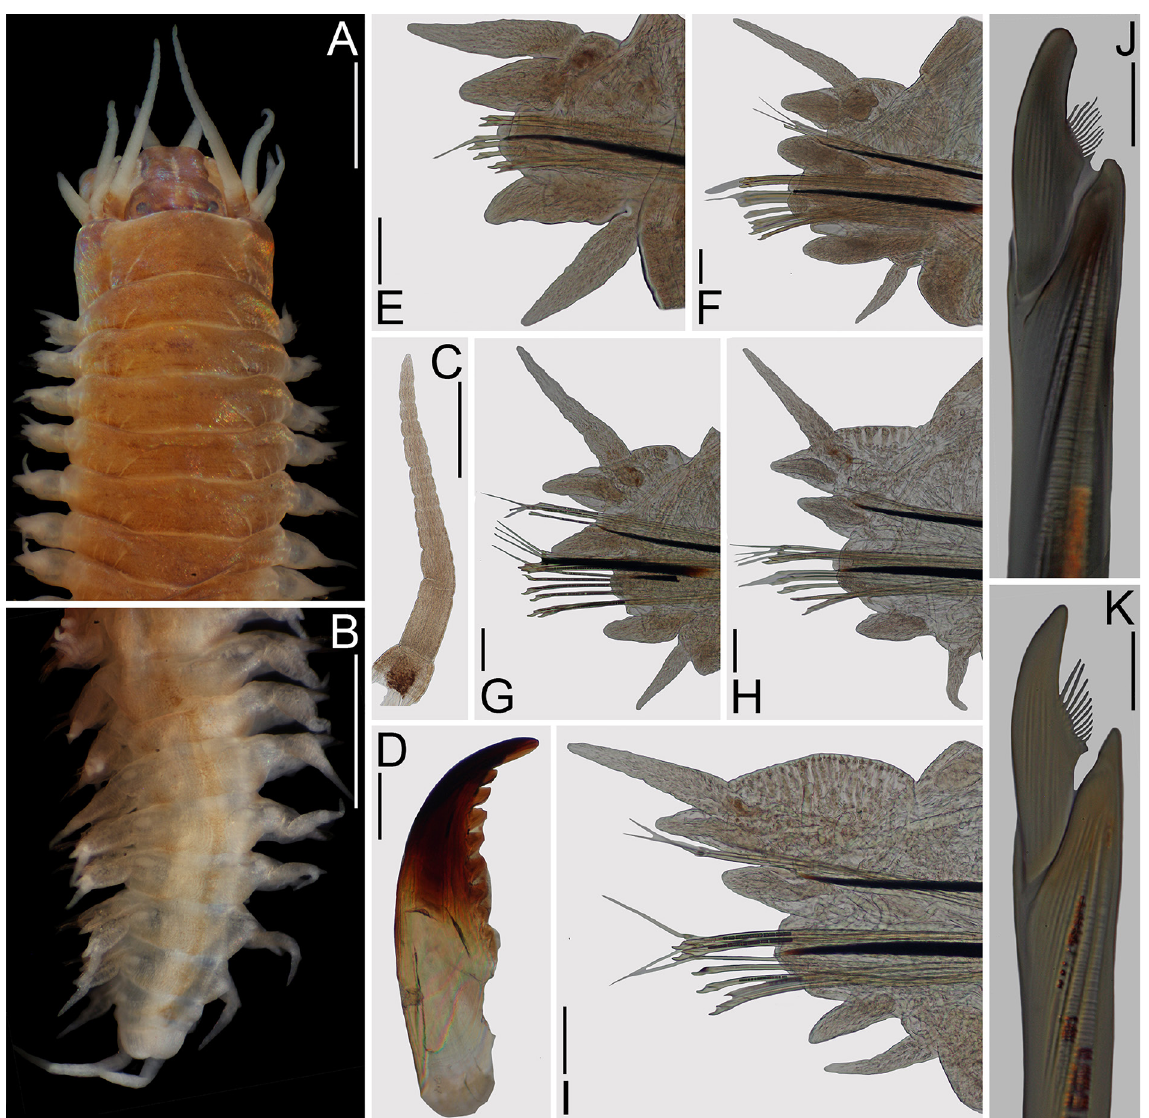
Fig. 2. Perinereis anderssoni Kinberg, 1865. Topotype (ECOSUR P3208). A . Anterior end, dorsal view. B . Posterior end, dorsal view. C . Posterodorsal tentacular cirri . D . Left jaw, dorsal view. E . Chaetiger 1, right parapodium. F . Chaetiger 10, right parapodium. G . Chaetiger 28, right parapodium. H . Chaetiger 45, right parapodium. I . Chaetiger 62, right parapodium. J . Supra-acicular heterogomph falciger, chaetiger 62. K . Sub-acicular heterogomph falciger, chaetiger 28. Scale bars: A–C = 1 mm; D = 0.25 mm; E–I = 0.1 mm; J–K = 10